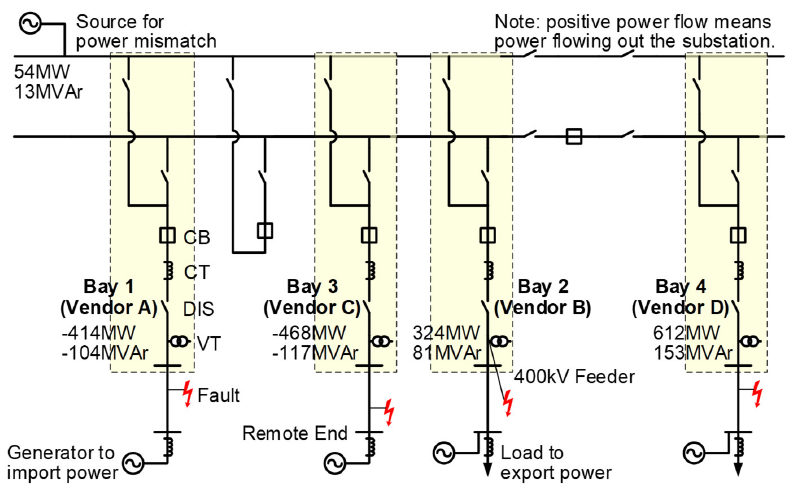
Figure 3. Simulated virtual 400 kV substation model in RTDS.